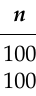
Table 1. Demographic profile of this study.